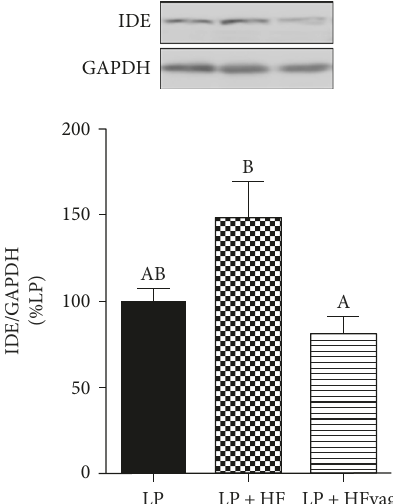
Figure 4: Vagotomy reduced IDE expression in the liver of the LP mice. IDE protein expression in the liver of the LP, LP+ HF, and LP +HFvag mice. Data are means ± SEM from the LP ( n = 6 ); LP +HF ( n = 5 ); and LP +HFvag ( n = 4 ). Di ff erent letters over the bars indicate signi fi cant di ff erences. One-way ANOVA followed by Tukey ’ s test. P < 0 05